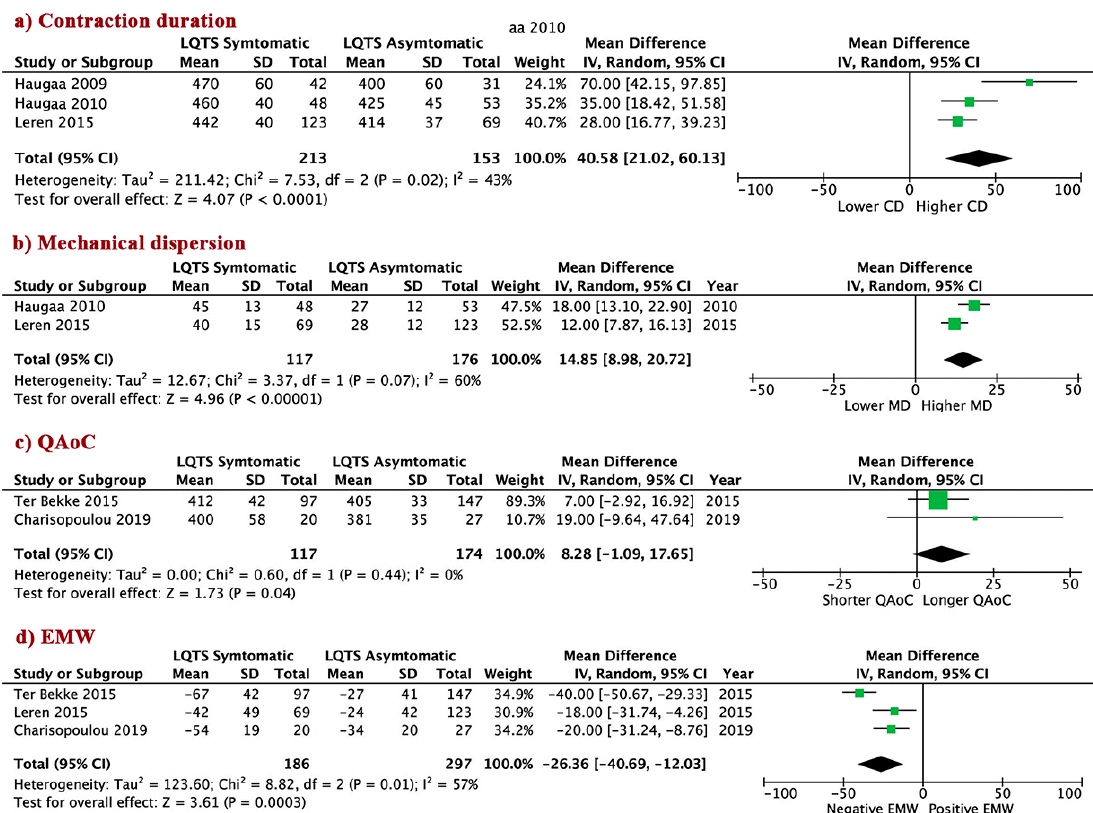
Figure 2. Mechanical abnormalities in LQTS patients—comparison of symptomatic vs. asymptomatic patients. ( a ) Conctraction duration; ( b ) Mechanical dispersion; ( c ) QAoC; ( d ) EMW. LQTS: long QT syndrome; QAoC: QRS onset to peak systolic strain, EMW: electro-mechanical window; CD: contraction duration; MD: mechanical dispersion